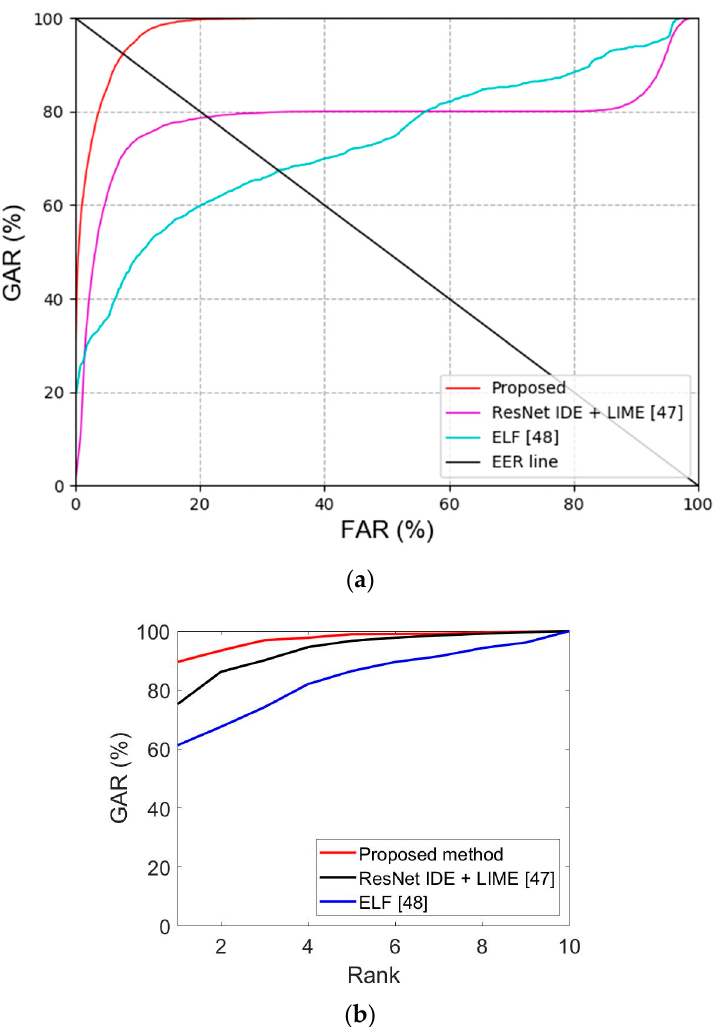
Figure 23. Comparisons of ( a ) ROC and ( b ) CMC curves obtained by proposed method and state-of-the-art-methods. Table 18. Comparison of EERs using the proposed method and state-of-the-art body and face recognition methods (unit: %).